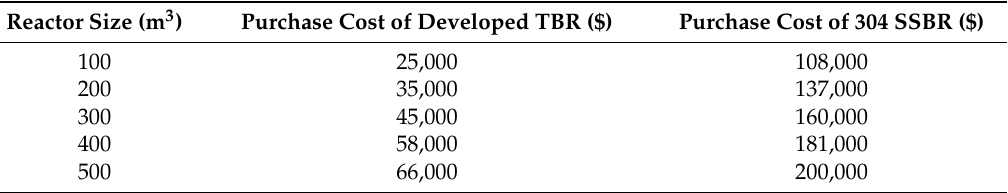
Table 2. Comparative procurement cost for APCCF bioreactor and 304-SSBR